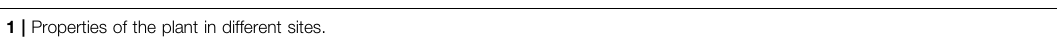
TABLE 1 | Properties of the plant in different